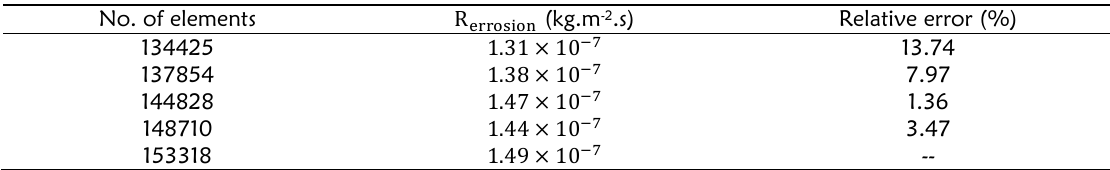
Table 1: Grid independence test